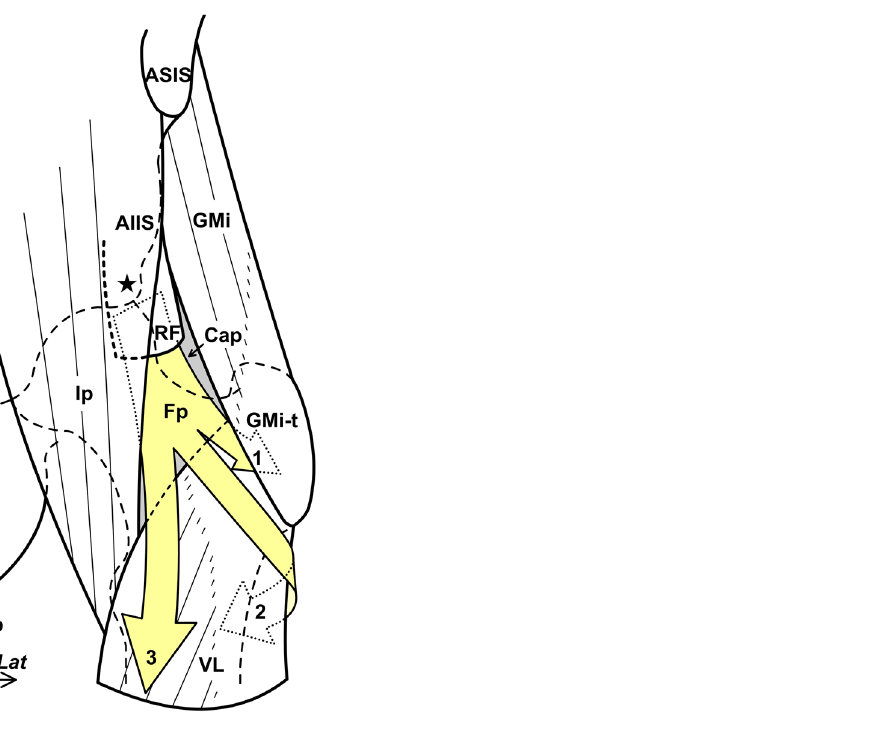
Figure 2. Schematic diagram indicating the spatial distribution of the fat pad on the AIIS. The schematic diagram of the anterior aspect of the left hip. The fat pad (Fp) deep to the rectus femoris (RF) and superficial to the joint capsule (Cap) were surrounded by the lateral portion of the iliopsoas (Ip) and the medial portion of the gluteus minimus (GMi). It extended distally, deep to the gluteus minimus tendon (GMi-t, fat pad extension was indicated by arrow no. 1) and posterolaterally to the anterior portion of the gluteus maximus tendon (extension was indicated by arrow no. 2) and superficial to the vastus lateralis (VL, extension was indicated by arrow no. 3). AIIS anterior inferior iliac spine, ASIS anterior superior iliac spine, Star: inferior area of the AIIS; Lat lateral; Sup